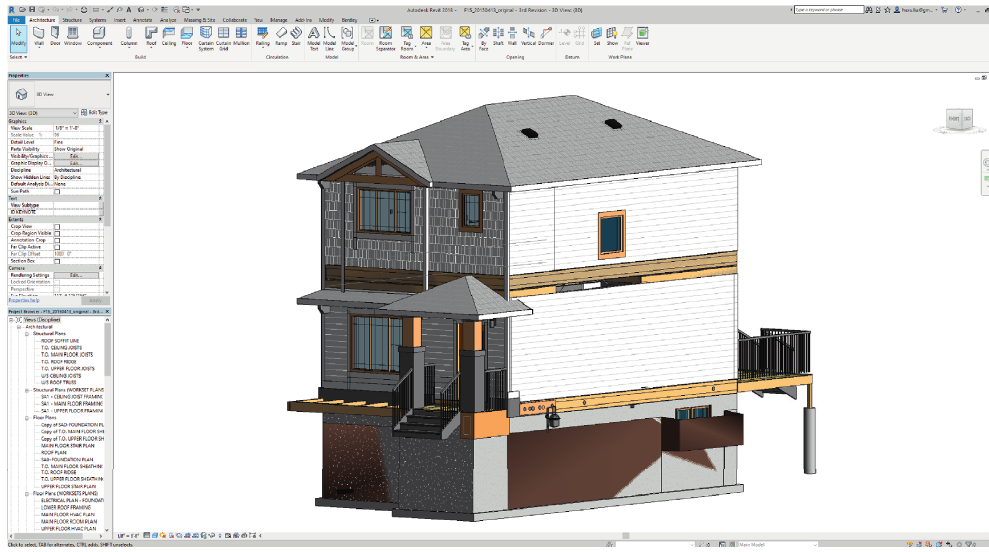
Figure 7: A residential home case study: 3D view.